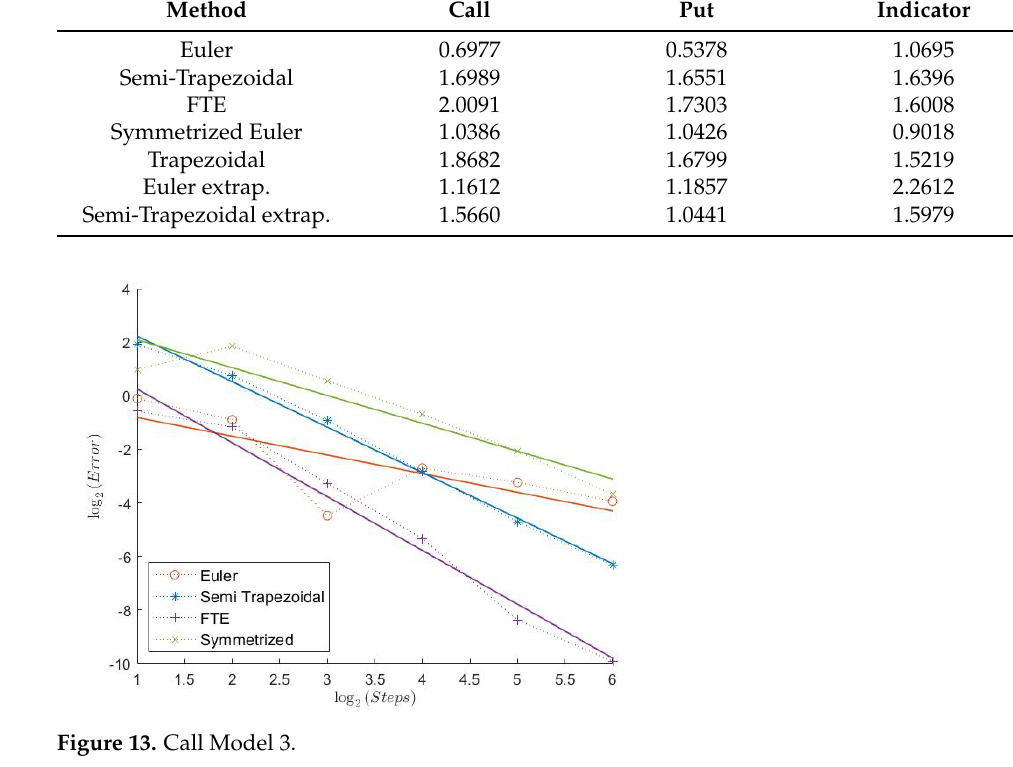
Figure 13. Call Model